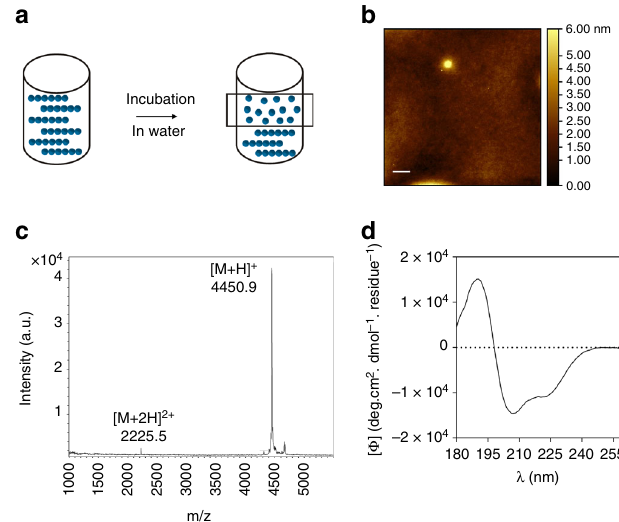
Fig. 3 Characterization of released peptide. a – d Schematic of the stability study a with examples of a representative AFM image b , mass spectrum c and far-UV CD spectrum d of released Oxm in water. Scale bar, 1 μ